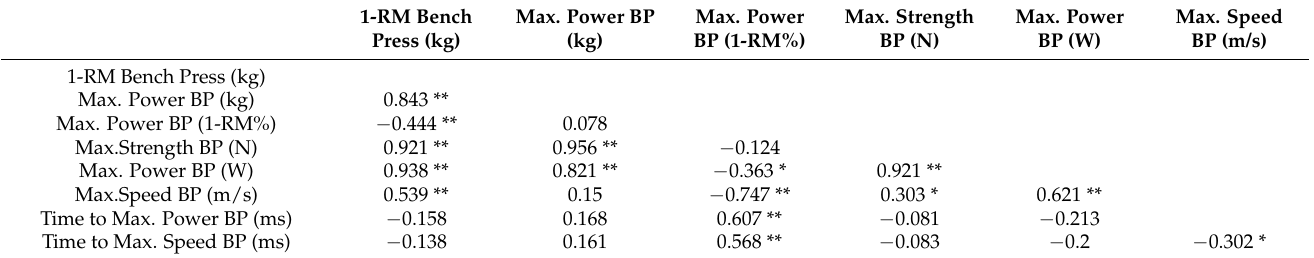
Table 5. Correlation among bench press